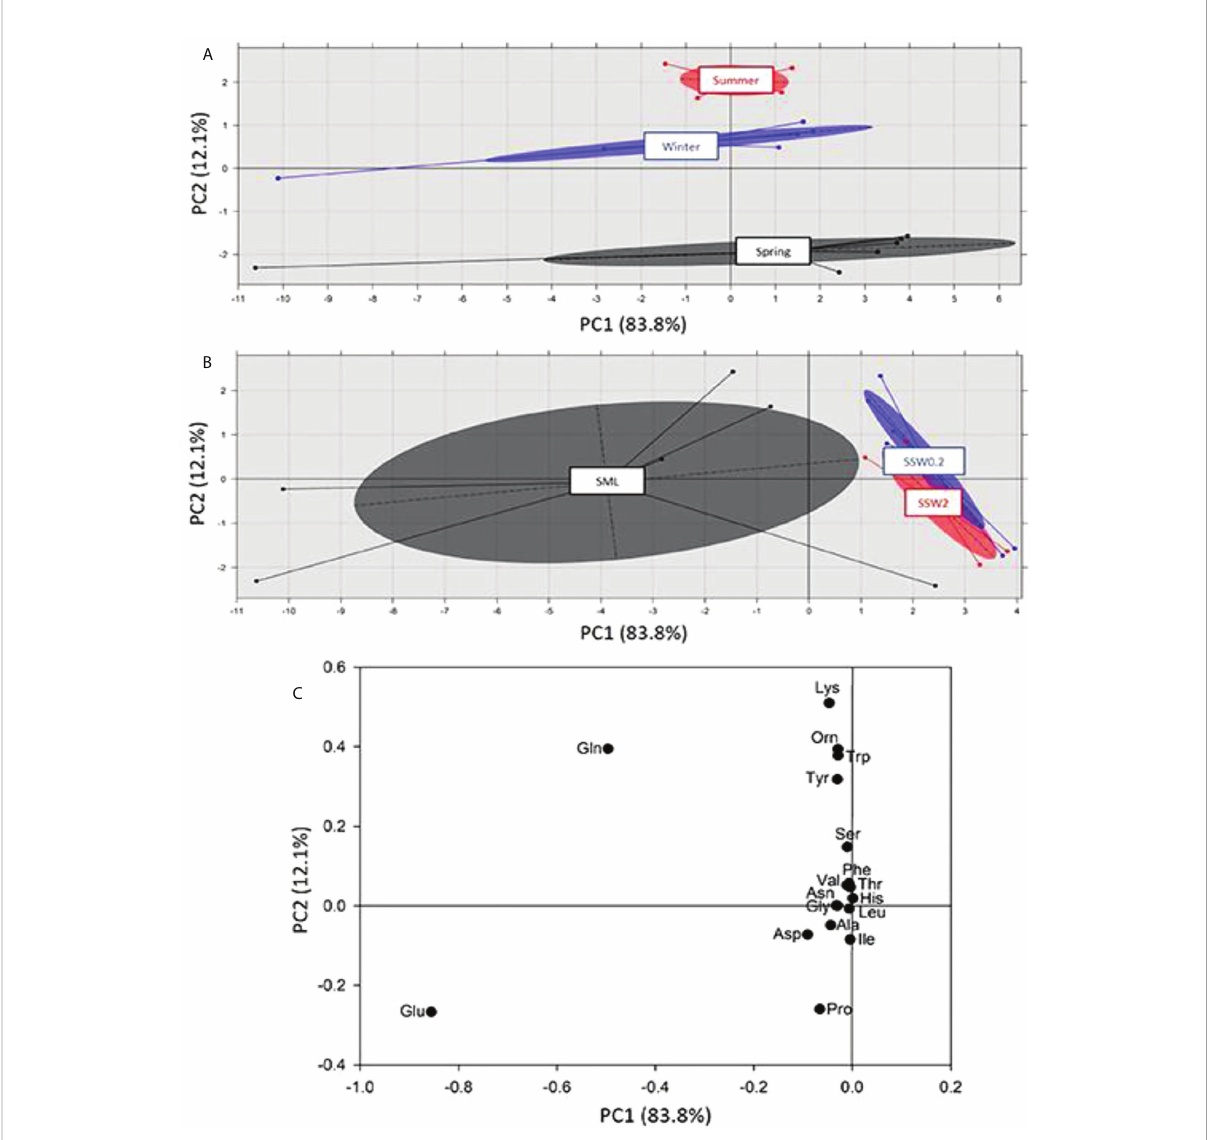
FIGURE 7 Principal component analysis of free amino acids (FAAs) content and separation on the basis of (A) sampling season, and (B) sampling depth. In (C) the loadings of PC2 across of which the separation is taking place are